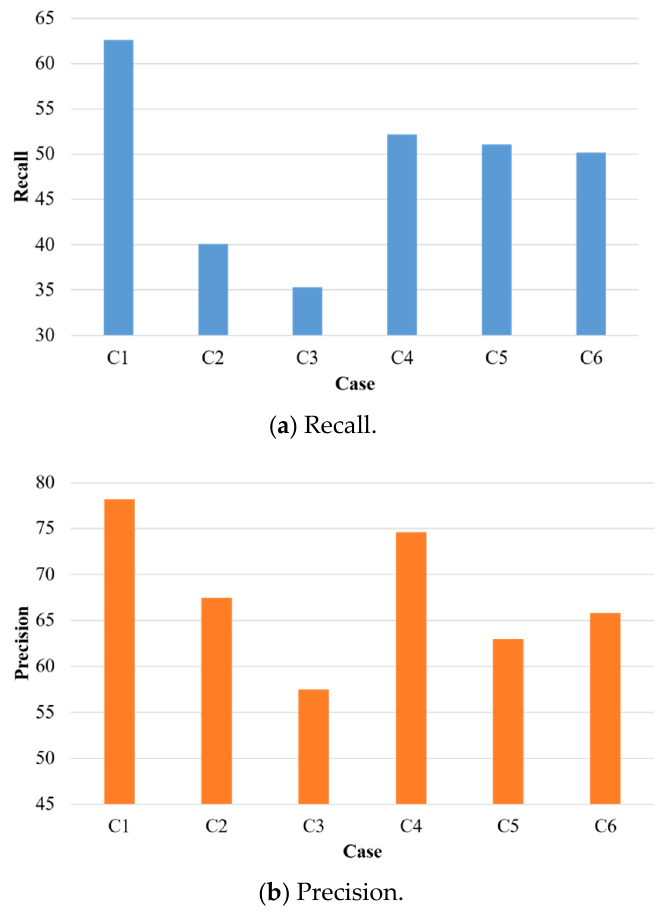
Figure 8. Recall and Precision according to weight value. Table 3. Expert recommendation